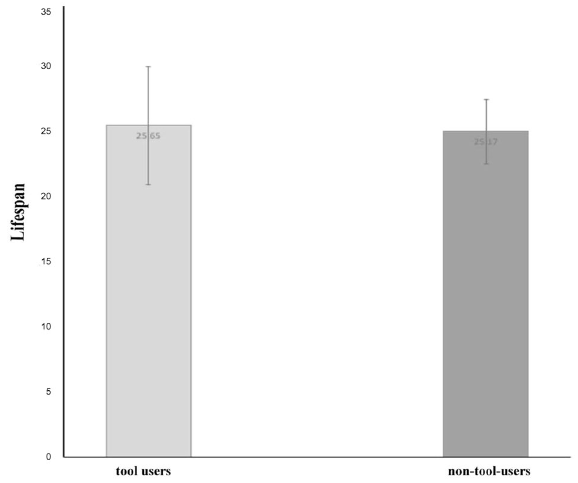
Figure 5. Mean life span in years with standard errors is presented for tool users (N = 26) and non-tool users (N = 48). There is no significant difference between these two groups.